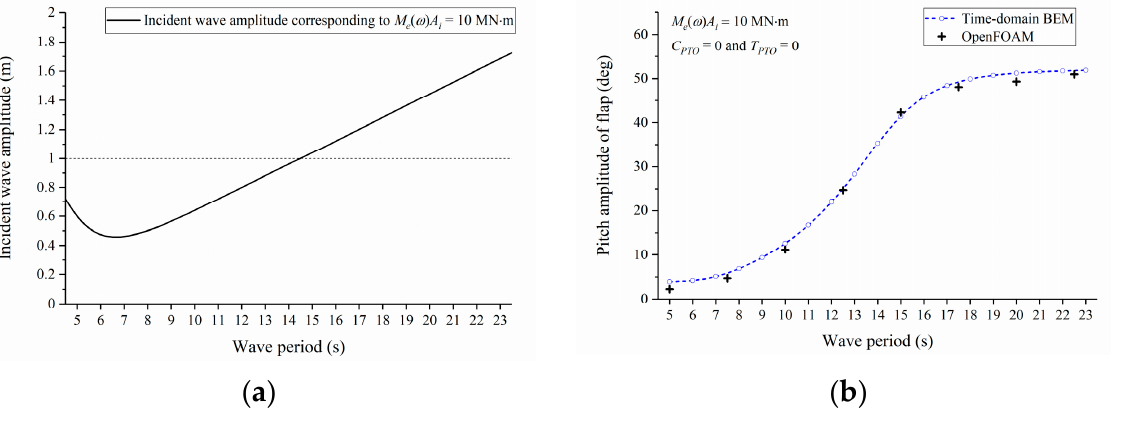
Figure 18. The parameters and results for regular waves of uniform wave exciting moment amplitude 10 MN · m: ( a ) the incident wave amplitude vs. period; ( b ) comparison between BEM and CFD of a flap without a PTO system ( 𝐶 (cid:3017)(cid:3021)(cid:3016) = 0 and 𝑇 (cid:3017)(cid:3021)(cid:3016) = 0 ).